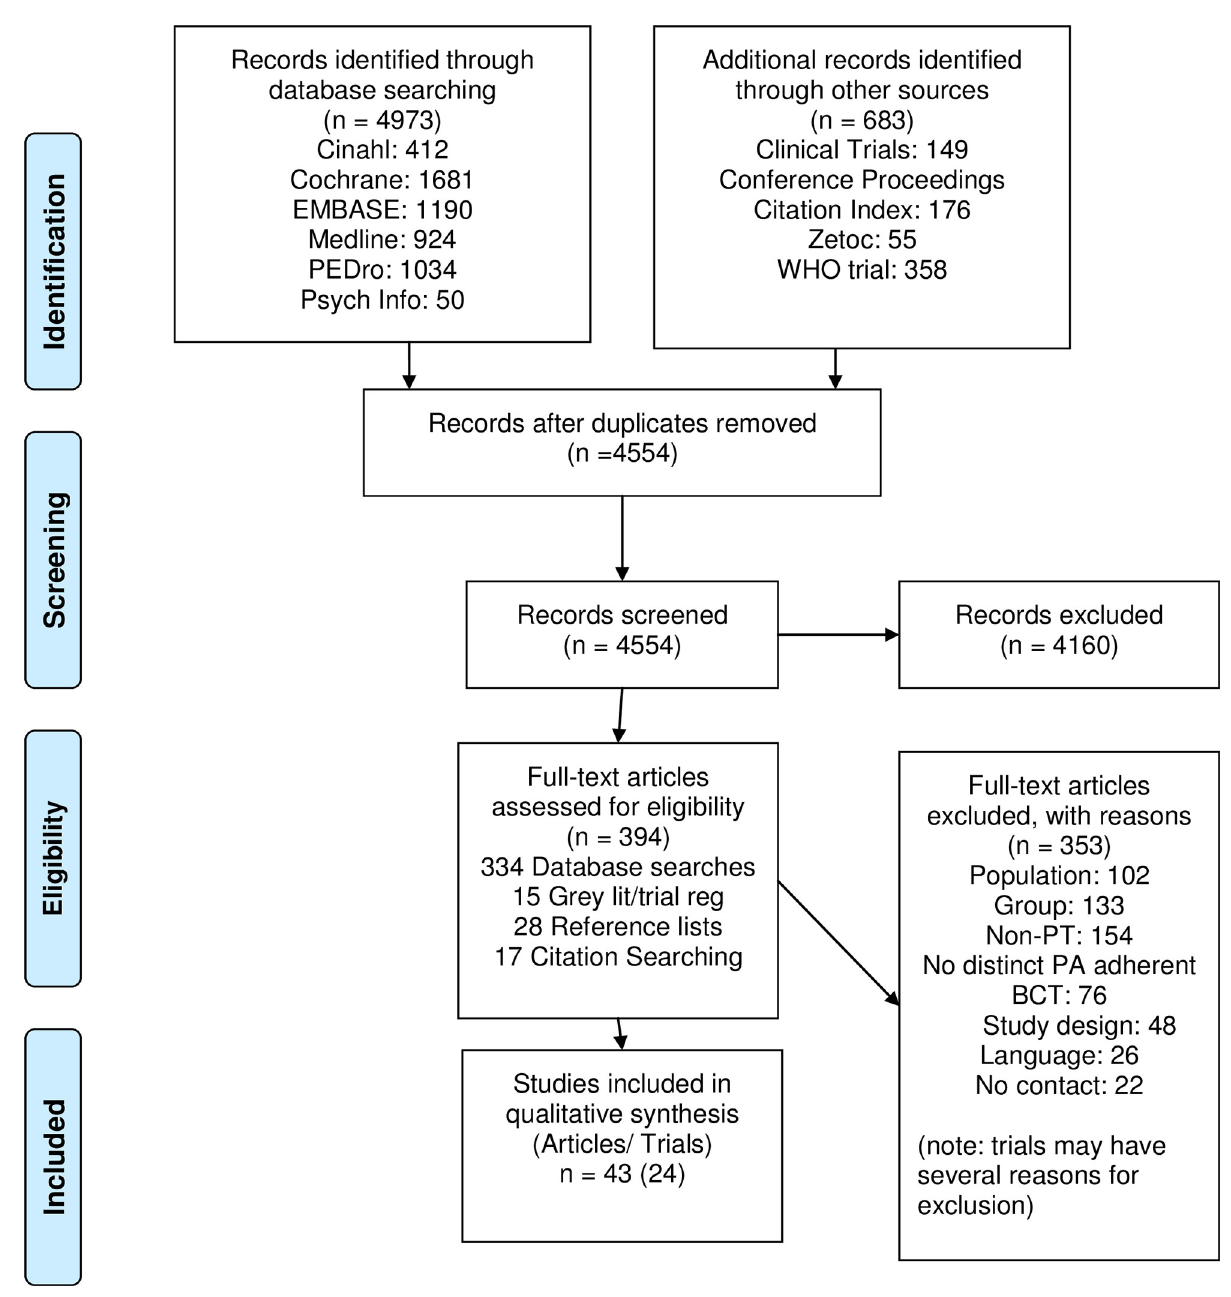
Fig 1. RCT selection flow